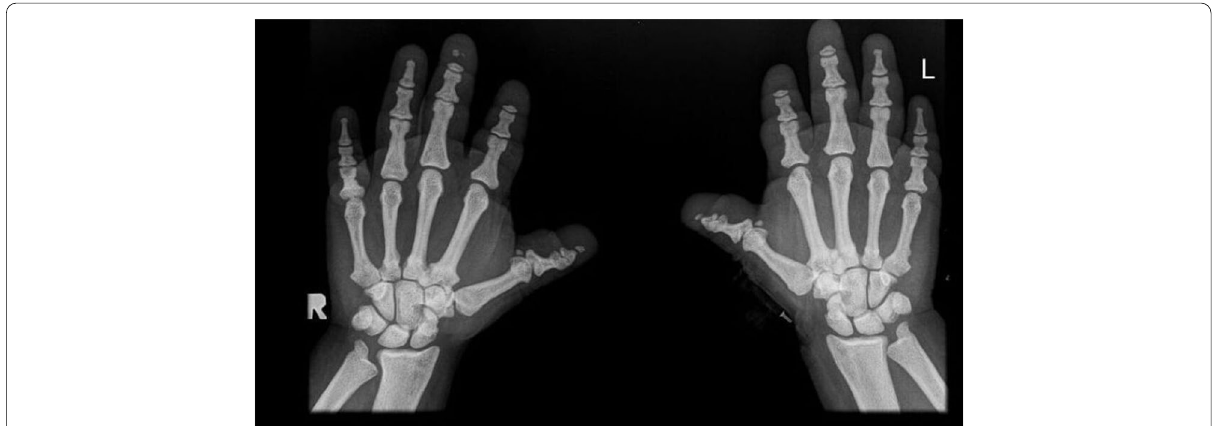
Fig. 1 Short and stubby hands with distal phalanx acro-osteolysis of thumb, index and middle fingers of both hands